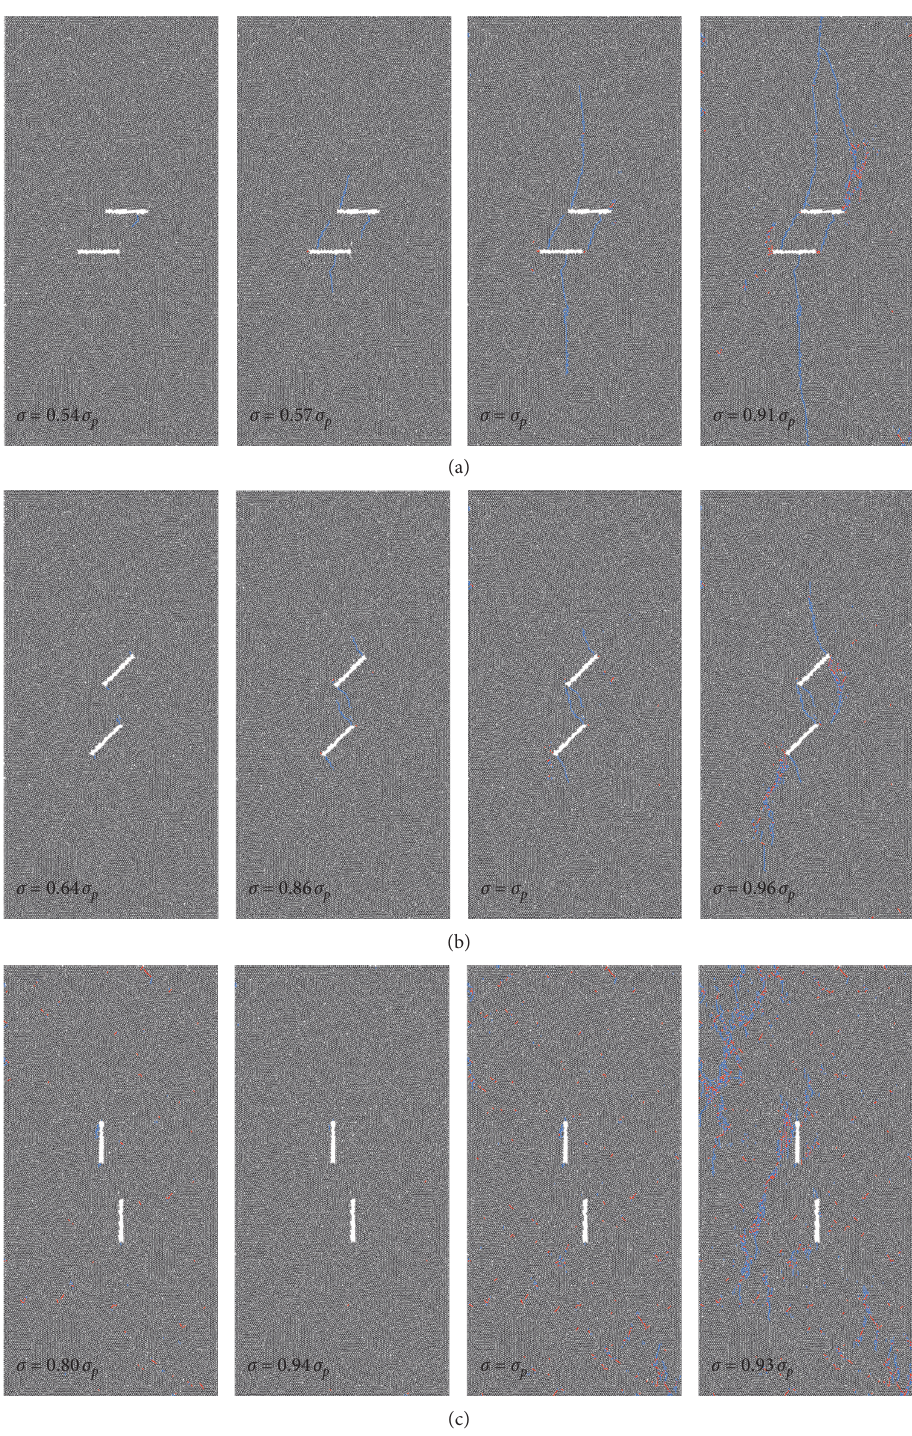
Figure 4: Crack development process of samples containing unfilled flaws with the same β of 120 ° and different α of 0 ° , 45 ° , and 90 ° (blue cracks represent tensile cracks and red cracks represent shear cracks). (a) α � 0 ° and β � 120 ° ; (b) α � 45 ° and β � 120 ° ; (c) α � 90 ° and β � 120 °